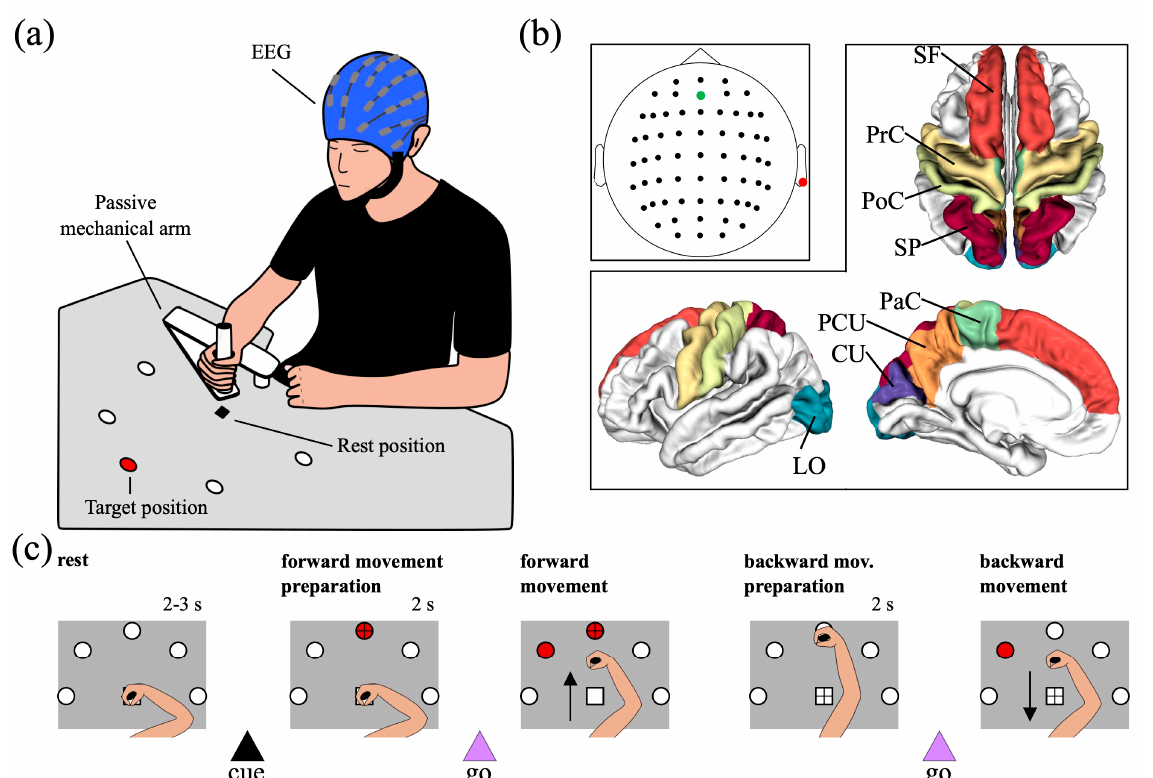
Figure 1. ( a ) Schematics of the recording setup. ( b ) Location of electrodes and regions of interest (ROIs). The electrodes were placed according to the 10/10 system and the ROIs considered in this study were taken from the Desikan–Killiany atlas. The reference channel (right earlobe) is marked in red, while the ground channel (AFz) in green. The selected ROIs were the cuneus (CU) and lateral occipital (LO) cortices as occipital regions, the precuneus (PCU) and superior parietal (SP) cortices as parietal regions, the post-central gyrus (PoC), the precentral gyrus (PrC), and the paracentral lobule (PaC) as peri-central regions, and the superior frontal gyrus (SF) as frontal region. ( c ) Trial sequence. Each trial started with a rest interval (2–3 s, random) that ended once a cue signal (target LED turning on) was provided to the participant indicating the target position. Then, the participant started preparing the center-out reaching movement (forward movement) and started the movement only after 2 s, once the first go-signal was provided (neighbor LED turning on). Once they reached the target, the participant held the position for 2 s while all LEDs were turned off. Finally, the second go-signal was provided (same as for the forward movement), triggering the backward movement toward the rest position. The fixation cross is displayed for each interval; note that, in the first scheme of panel c (rest interval 2–3 s), the fixation cross (at the rest position) is not visible since covered by the participants’